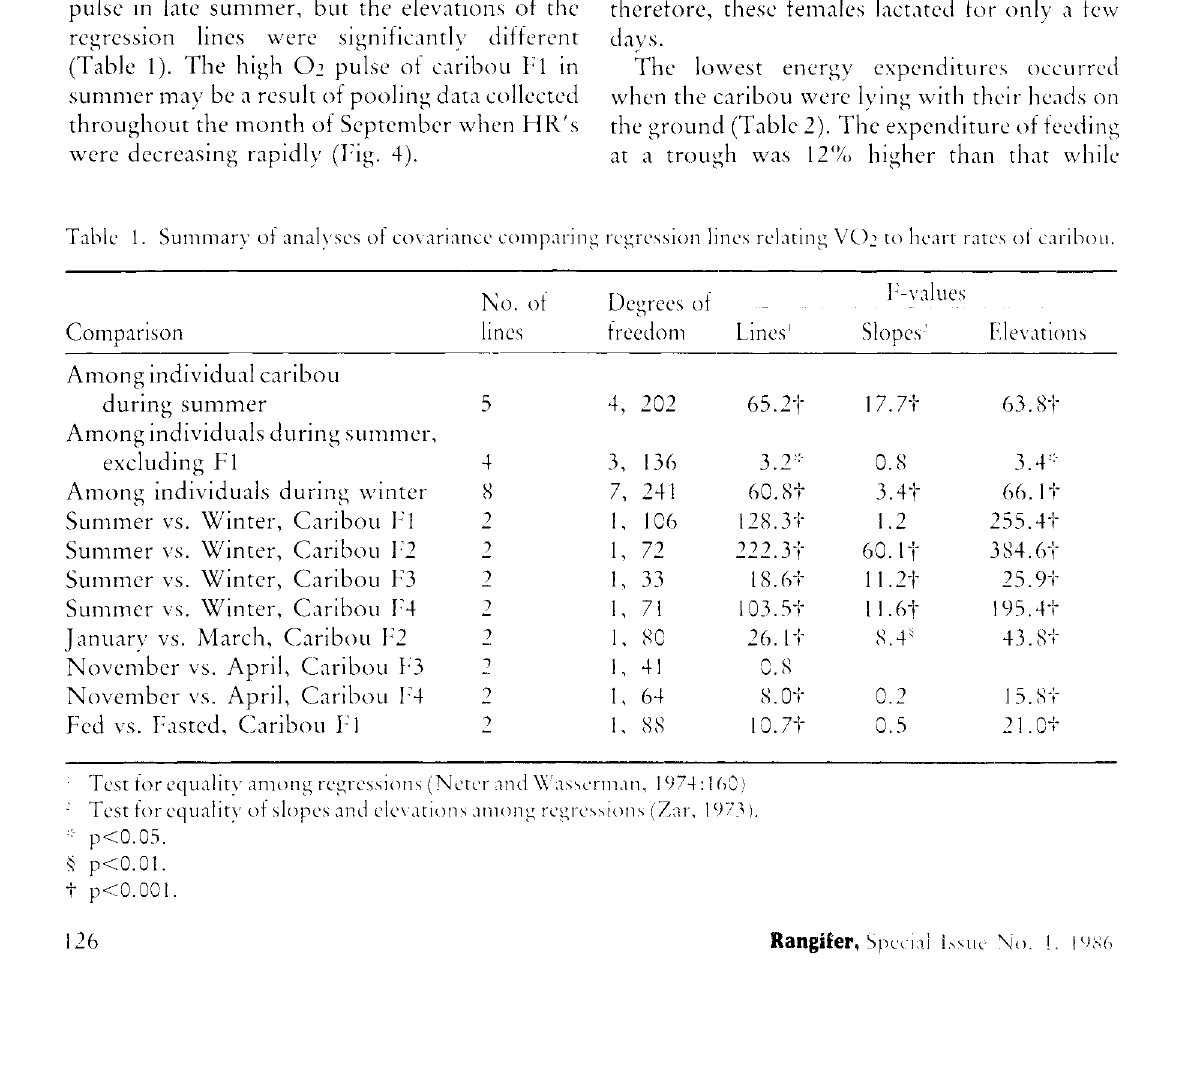
(Table 1). The high O2 pulse of caribou Fl in summer may be a result of pooling data collected throughout the month of September when HR's were decreasing rapidly (Fig.